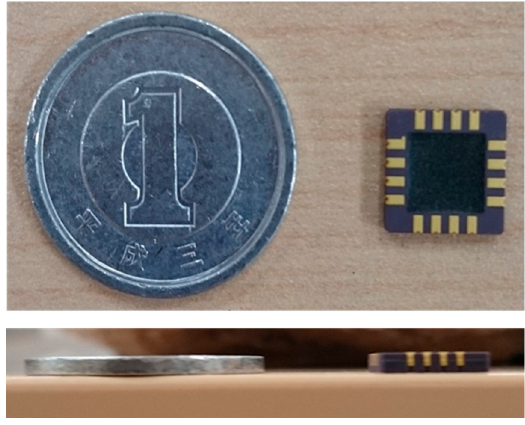
Figure 3. Nerve-net LSI chip packaged in